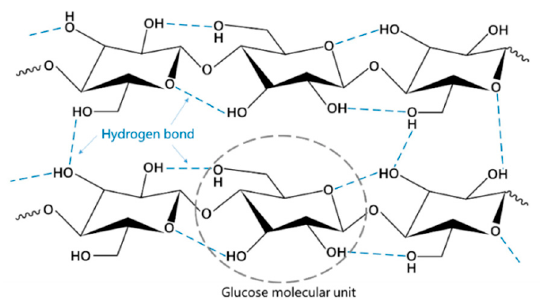
Figure 1. Molecular structure diagram of cellulose.